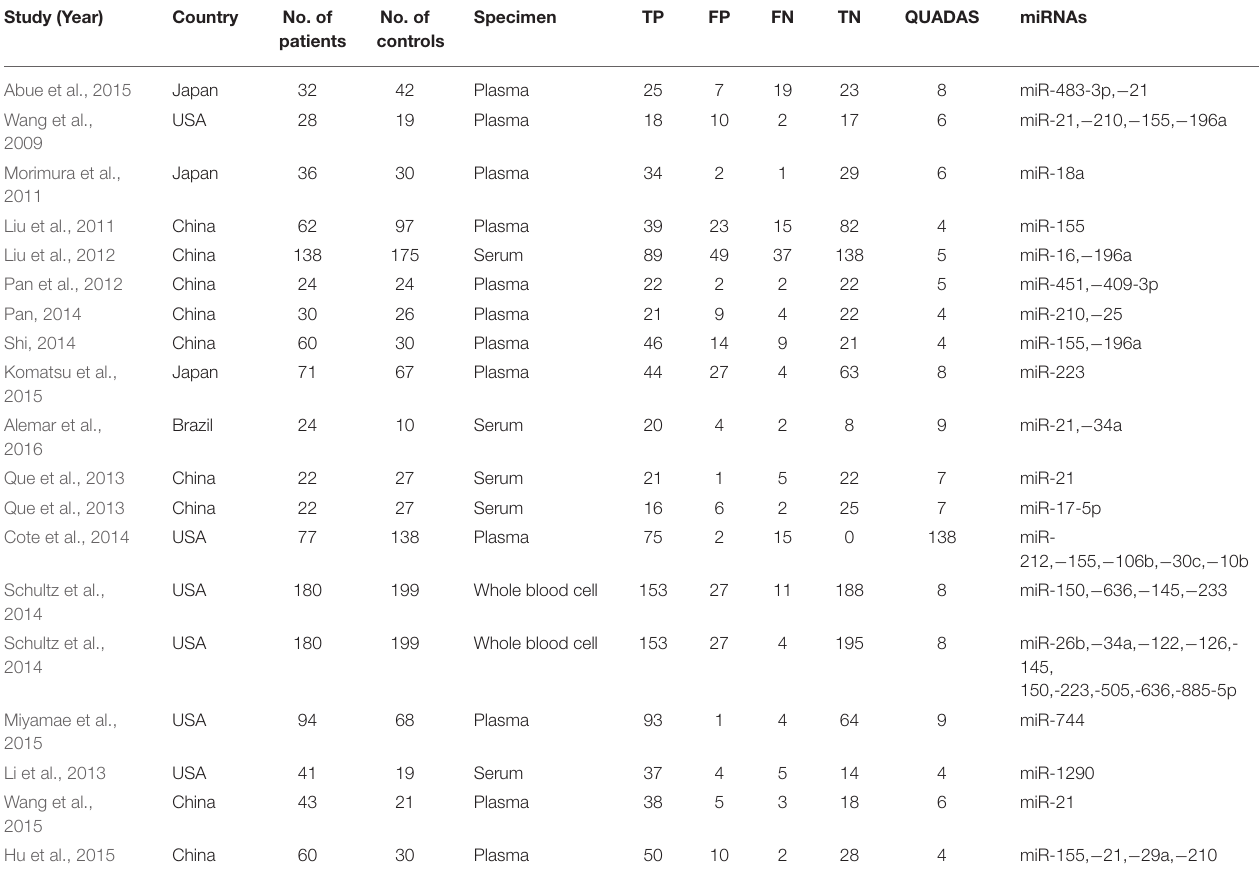
TABLE 1 | Summary of included